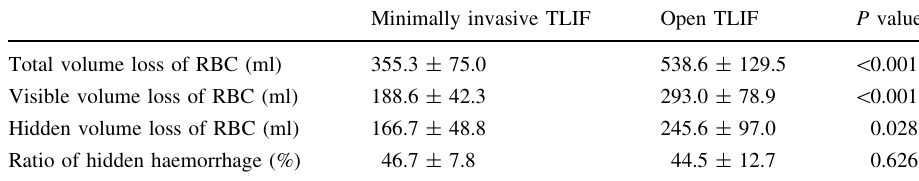
Minimally invasive